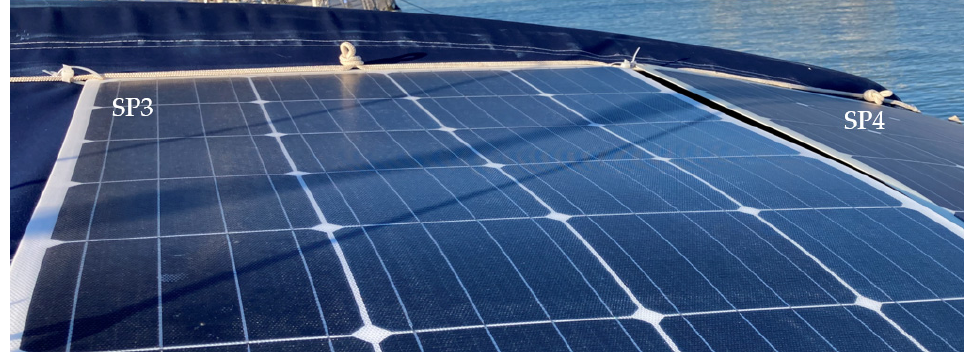
Figure 15. Shaded in SP3 and SP4 at 16:00 h in the position of the Sun at sunset from the Southwest.